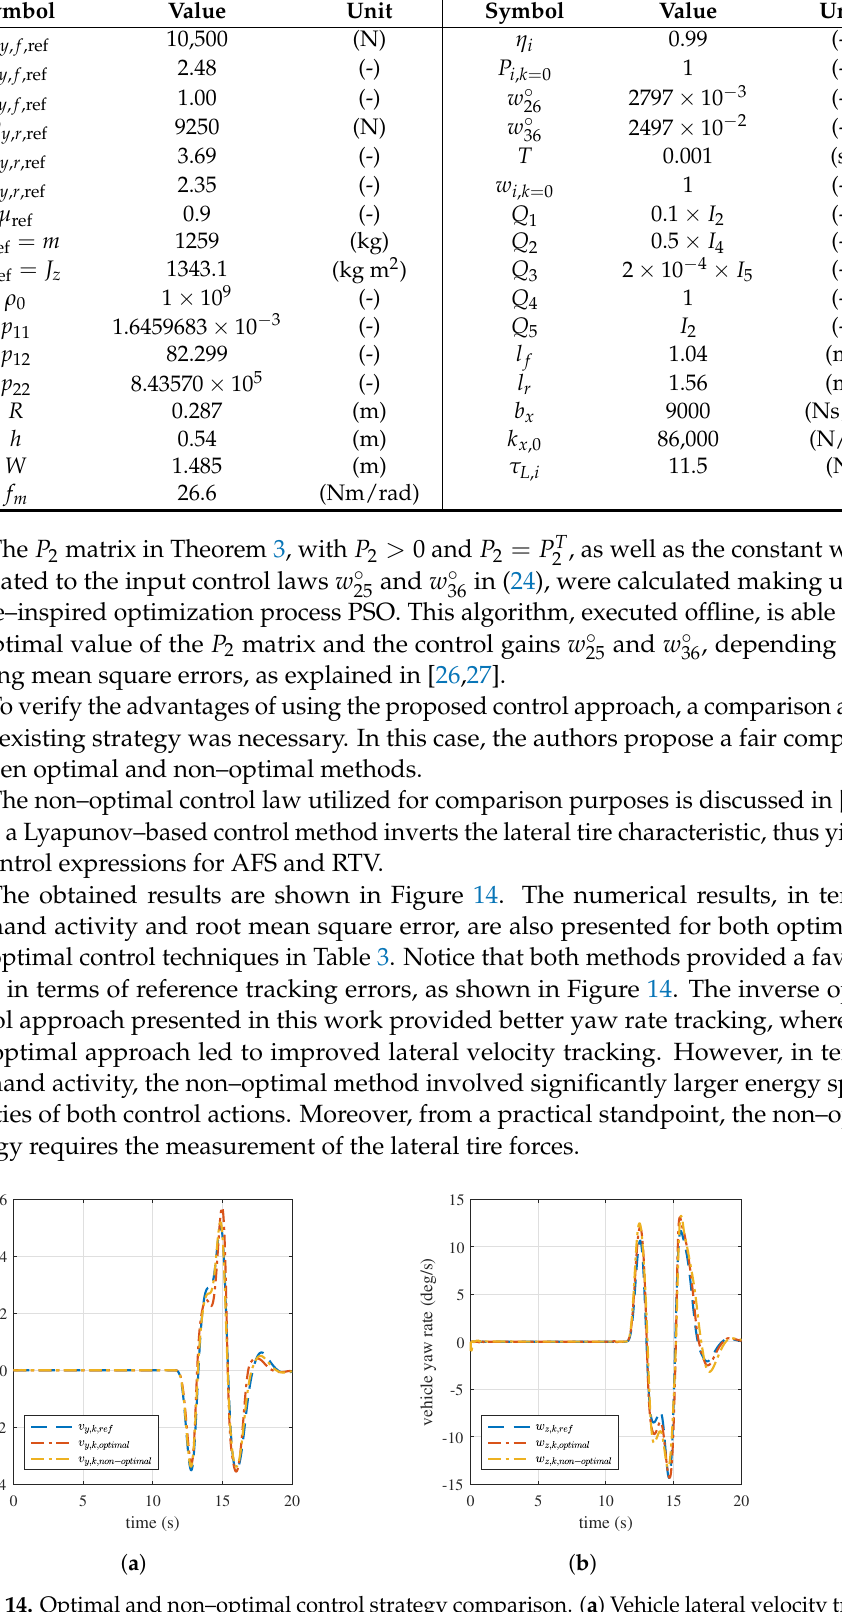
Figure 14. Optimal and non–optimal control strategy comparison. ( a ) Vehicle lateral velocity tracking. ( b ) Vehicle yaw rate